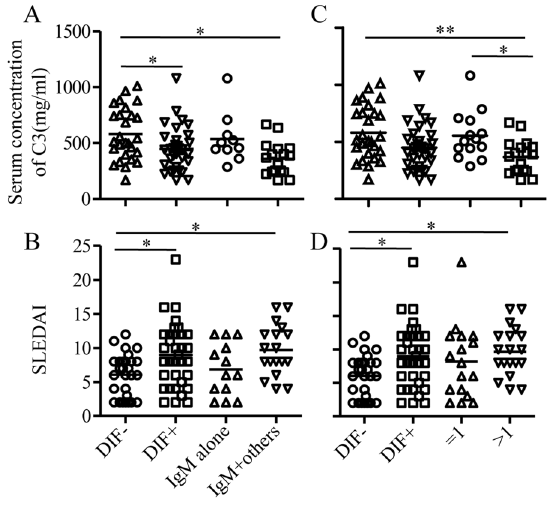
Figure 3. The comparison of serum C3 concentration and SLEDAI in groups of patients Patients were first divided into DIF 2 and DIF + groups. DIF + group was then divided into two subgroups according to the existence pattern (A, B) and the number of immunoreactants(C, D), respectively. Serum C3(A, C) and SLEDAI(B,D) were compared among each of four groups. Each symbol represents one individual, and the bar indicates the mean. Statistical analysis was performed with one-way analysis of variance followed by Dunn’s post hoc test for three groups. * P , 0.05, ** P , 0.01.